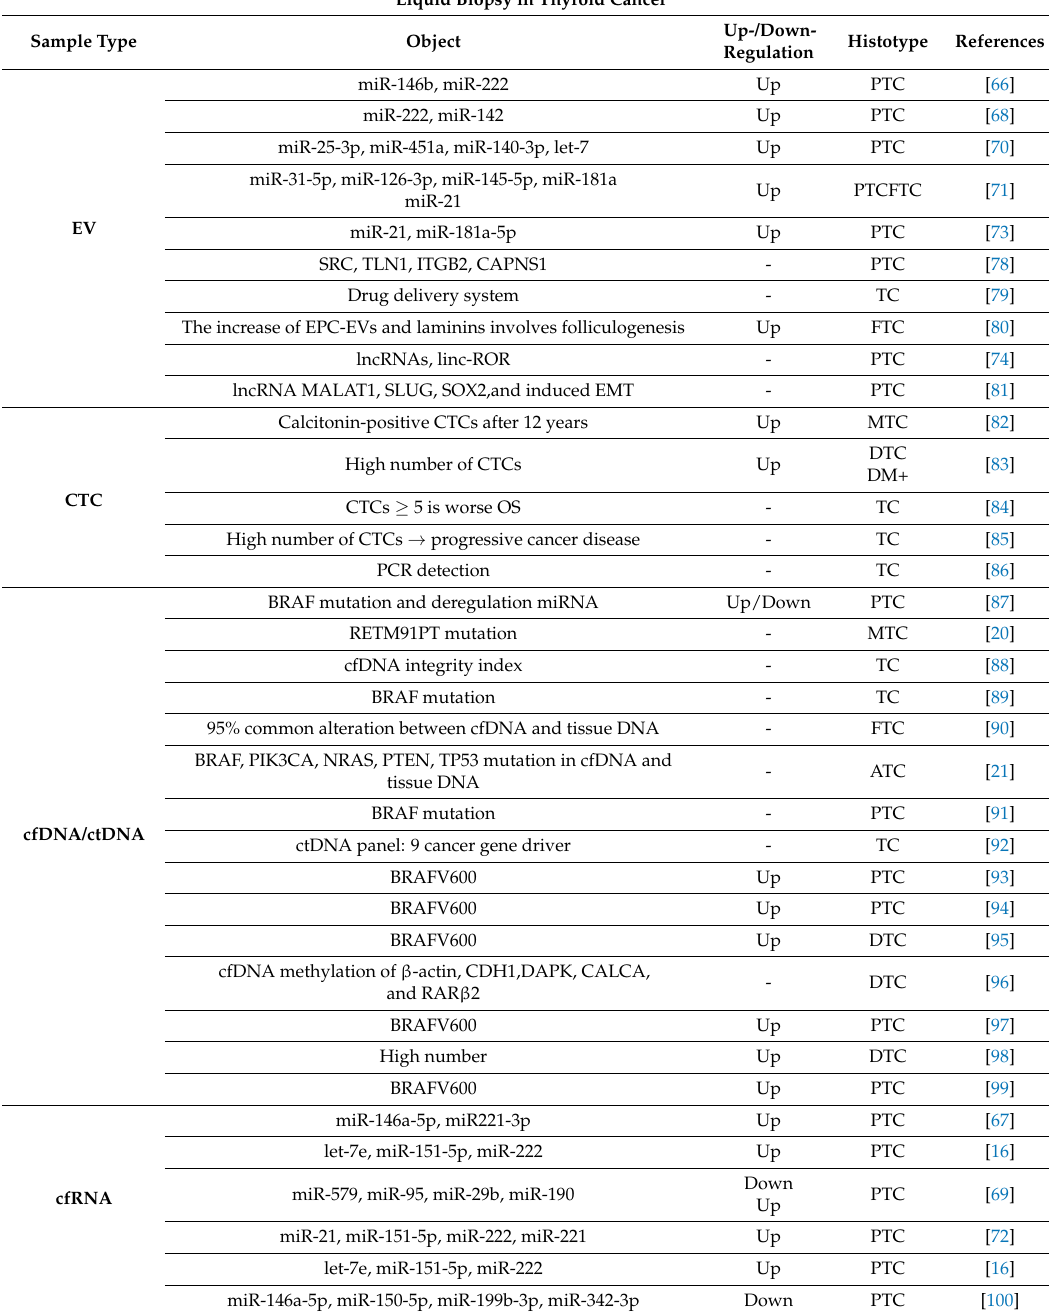
Table 1. Publications describing the use of extracellular vesicles, circulating tumor cells, cell-free DNA, and cell-free RNA for diagnosis and monitoring of thyroid